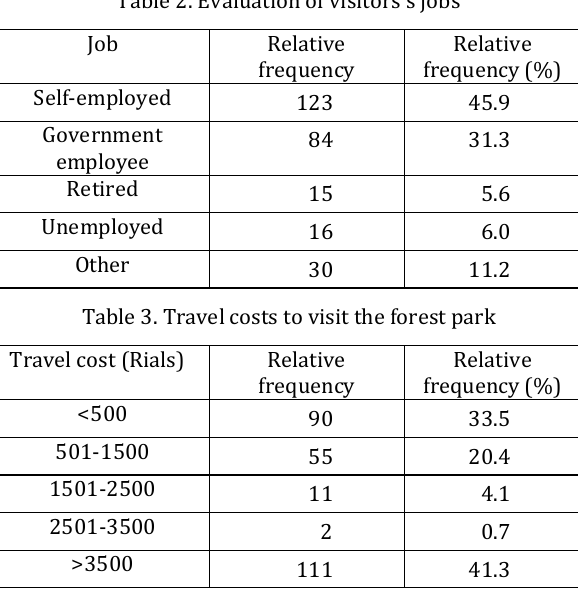
Table 2. Evaluation of visitors’s jobs